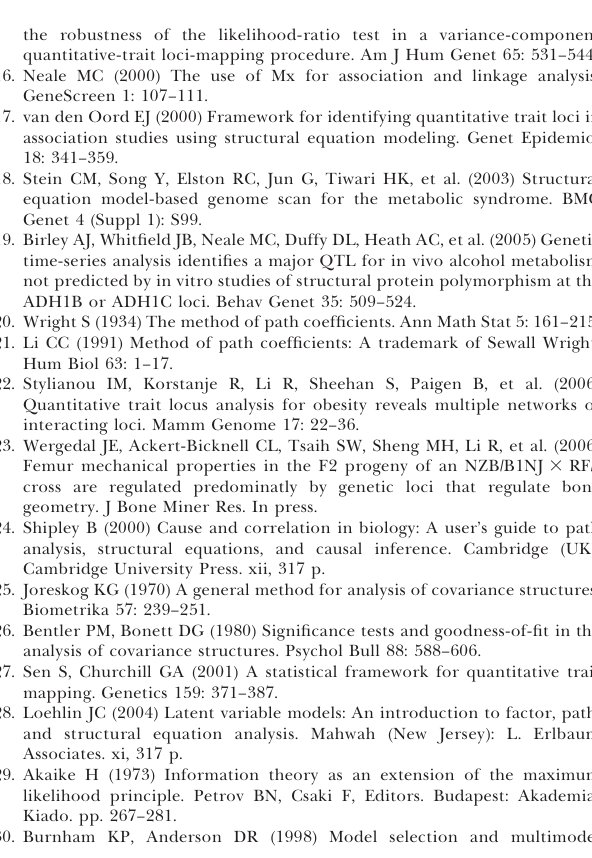
Table S1. Path Analysis of the Inguinal Fat Pad Model Table S2. Path Analysis of the Gonadal Fat Pad Model Table S3. Path Analysis of the Peritoneal Fat Pad Model Table S4. Path Analysis of the Mesenteric Fat Pad